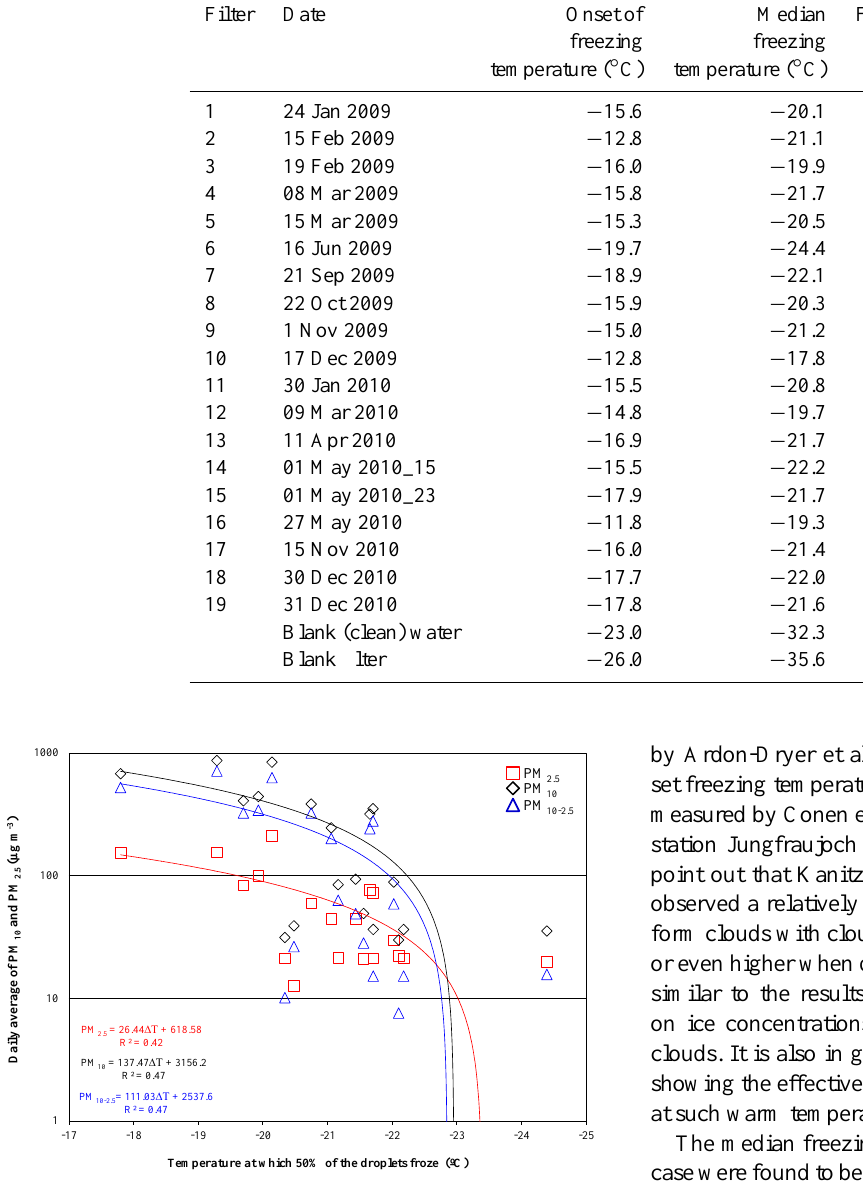
Figure 3. The connection between the median freezing temperature of the drops and the daily average values of PM 2 . 5 (in red), PM 10 (in black), and PM 10 –PM 2 . 5 (in